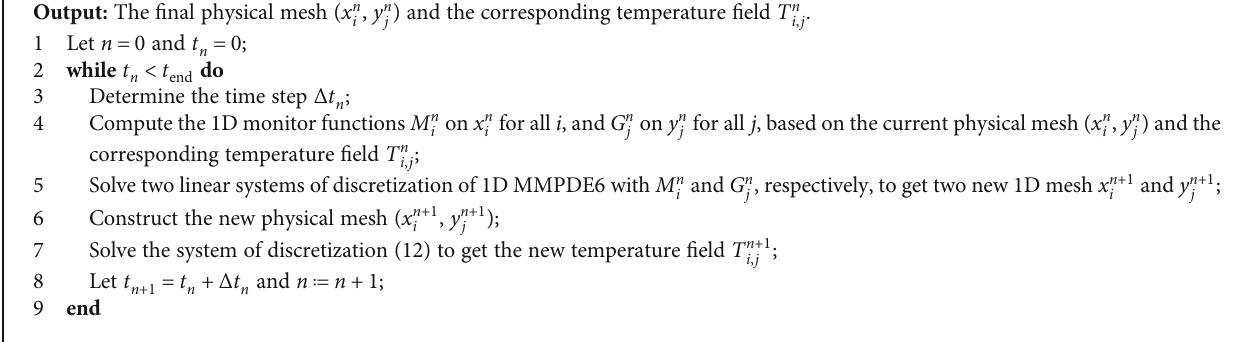
Algorithm 1. Flowchart of the moving mesh algorithm for moving heat source